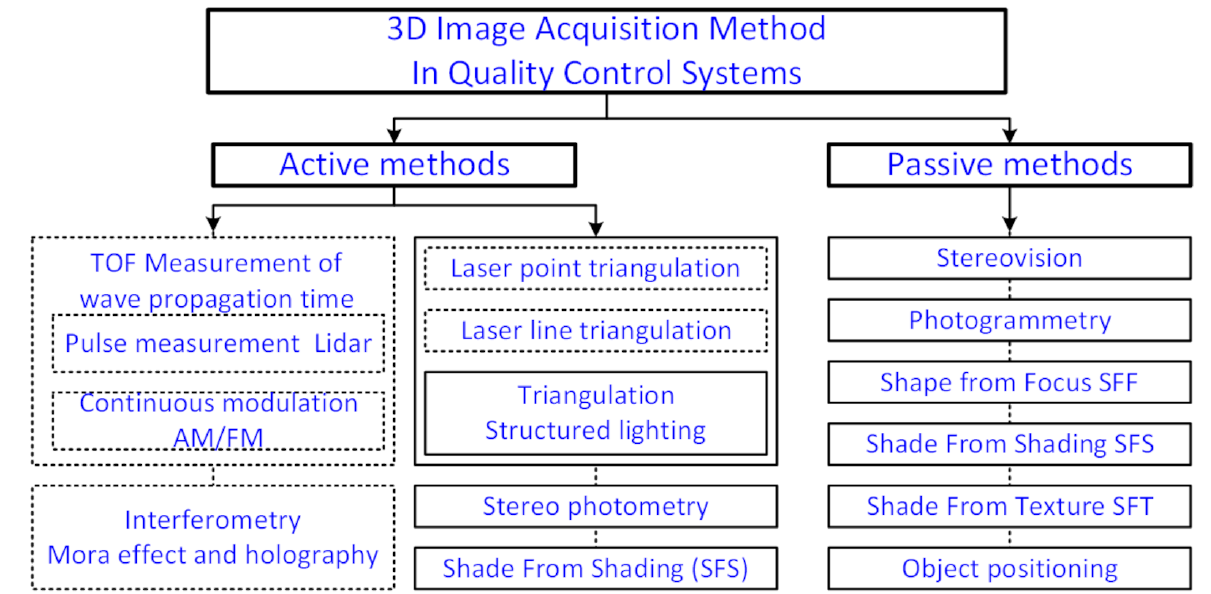
Figure 1. Methods of acquisition of three-dimensional images.